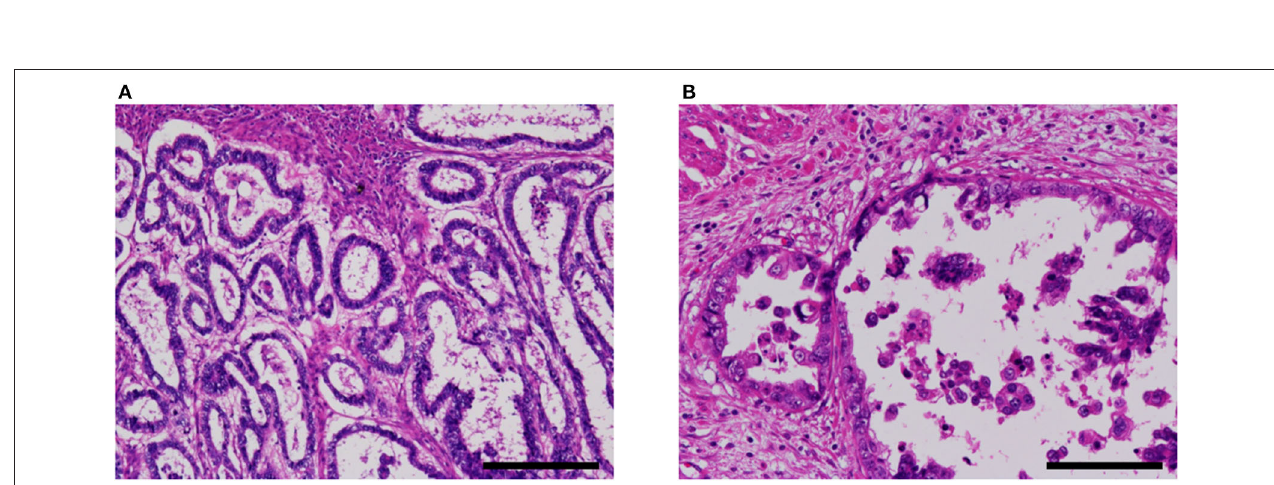
FIGURE 4 | Non-clear glandular pattern of α -fetoprotein-producing endometrial carcinoma (case 5). (A,B) This pattern was associated with smooth (A) or ragged (B) luminal border, which imparted low-grade endometrioid-like or clear cell carcinoma-like appearance, respectively. Hematoxylin-eosin; original magnification × 100 (A) and × 200 (B) ; scale bars = 200 µ m (A) and 100 µ m (B) .